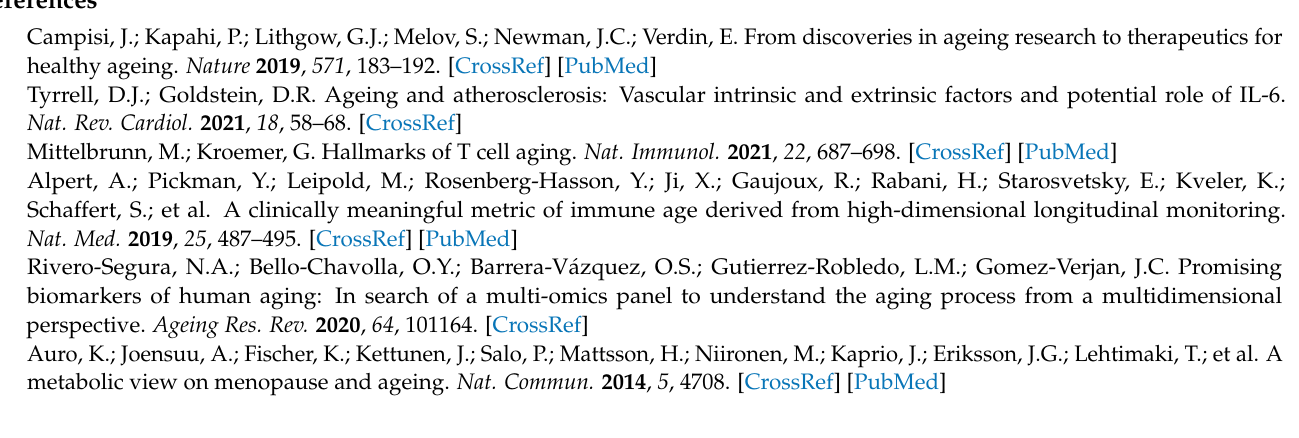
ers; Table S1: Composition of normal chow diet; Table S2: Pathway analysis of significantly altered metabolites (pos: red color; neg: blue color); Table S3: Serum biomarkers identified in the negative and positive modes by machine